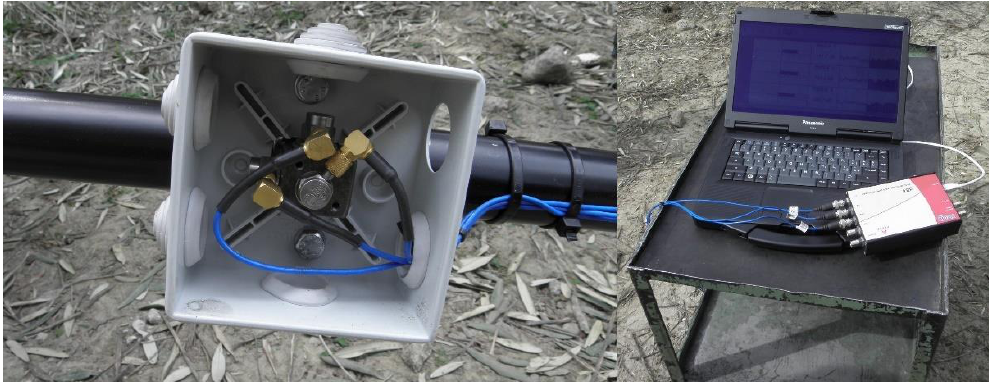
Figure 3. The accelerometers on the rod and the PC-based signal acquisition system.